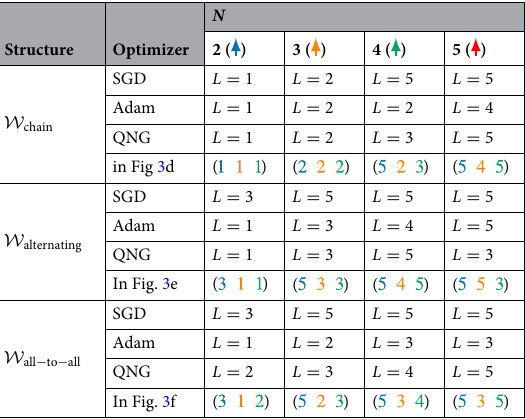
Table 1. Number of optimal layers L taking from Fig.